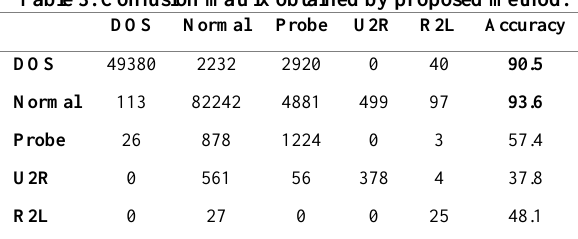
Figure 1. Proposed method procedure. Table 3. Confusion matrix obtained by proposed method.